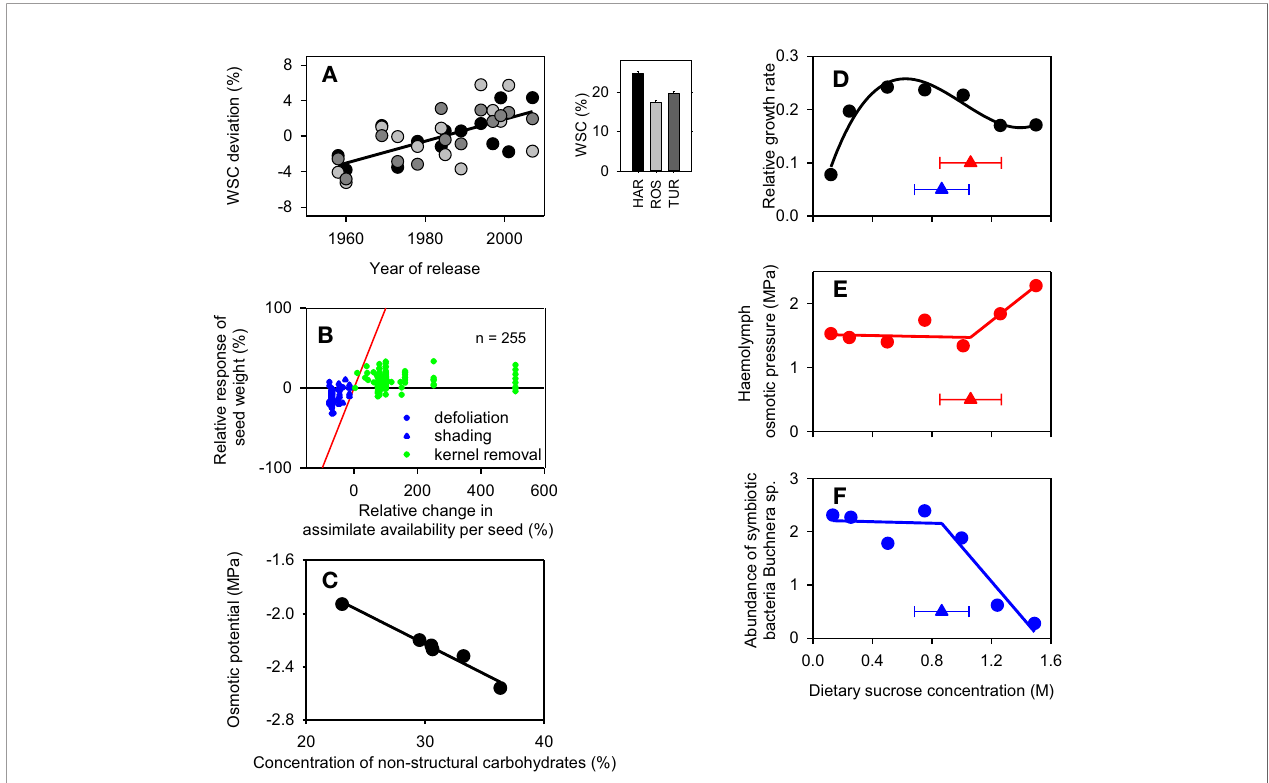
FIGURE 1 | (A) Selection for yield over fi ve decades steadily increased the concentration of water soluble carbohydrates (WSC) in wheat adapted to winter-rainfall environments of Australia. Inset is the average across varieties in three environments of South Australia (HAR: Hart, ROS: Roseworthy, TUR: Turret fi eld) and the scatterplot is the deviation of each variety relative to the environmental mean. The fi tted line is the least-square regression (r = 0.66, P < 0.0001). (B) Relationship between relative change in wheat seed weight and the relative change in potential assimilate availability per seed produced during seed fi lling in a number of experiments where source:sink ratio was reduced with defoliation or shading or increased with partial removal of kernels. The lines are the theoretical limits for full source limitation (y = x, red) and full source limitation (y = 0, black). (C) Correlation between the osmotic potential and concentration of nonstructural sugars (fructan + sucrose) of wheat plants in a factorial experiment comparing three cultivars (Froid, Brawny, PI 372129) infested with Russian wheat aphid ( Diuraphis noxia ) and uninfested controls. The fi tted line is the least-square regression (r = − 0.98, P < 0.001). (D) Relative growth rate of the pea aphid Acyrthosiphon pisum as a function of sucrose concentration in arti fi cial diet. Growth rate is log e (day-8 mass/day-6 mass)/2], with each aphid weighed on day 6 and day 8 to the nearest µg. (E) Osmotic pressure of the hemolymph of 8-day-old aphids reared on diets with varying concentration of sucrose. (F) . Abundance of symbioticbacteria Buchnera spp. in8-d-old aphids on diets of varying concentration ofsucrose. Abundance is10 − 6 × the number of copies of Buchnera dnak gene per ngtotal DNA. The fi ttedcurves are (D) cubicpolynomial, (E, F) piecewisemodelswithtrianglesshowing thebreakpoint±standarderror. Figureshavebeendrawnusing datafrom thefollowingsources: (A) SadrasandLawson(2011); (B) Borra ́ setal.(2004); (C) Storlieetal.(1993); (D – F) Douglaset al. (2006).The fi gureshavebeenreproducedwithpermissionbyCSIROPublishing (A) , Elsevier (B) , Springer Nature (C) andCompanyofBiologists, Societyfor ExperimentalBiology(GreatBritain) (D – F)